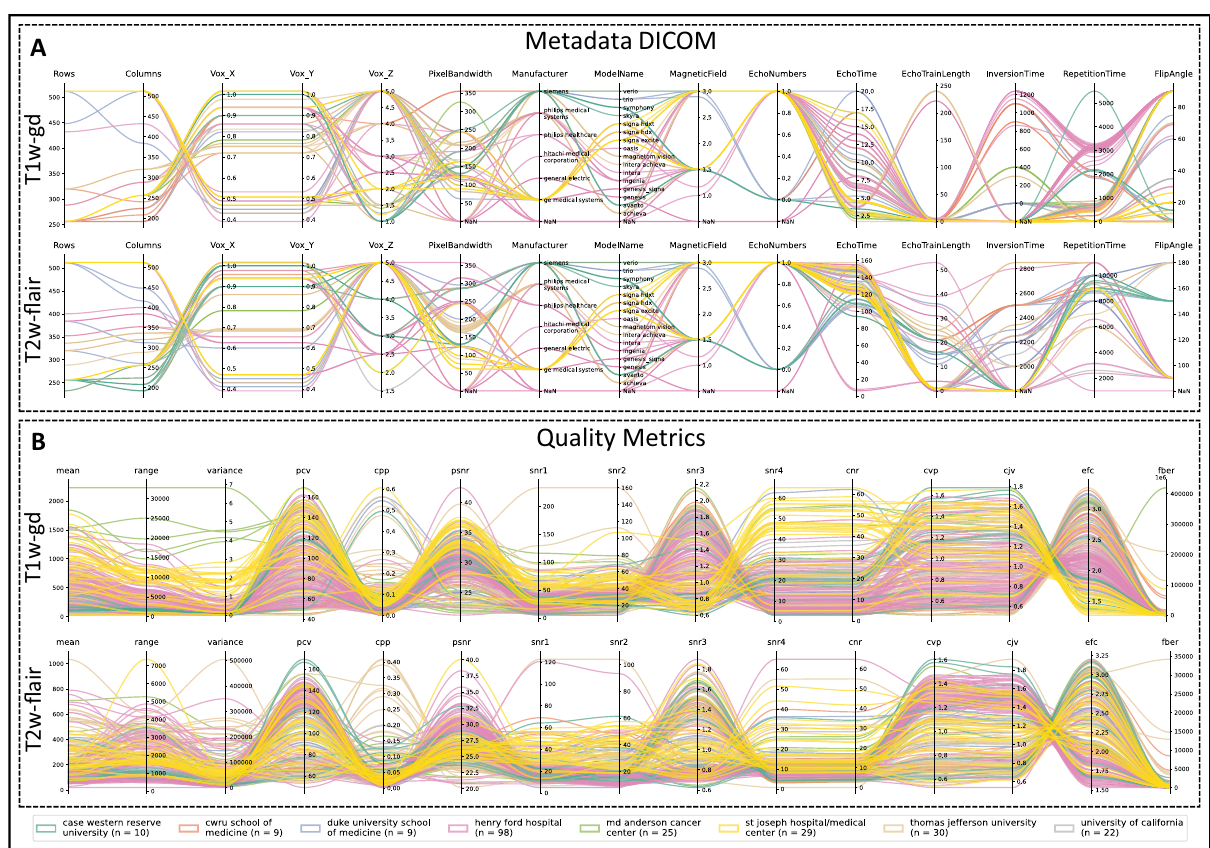
Figure 3. Parallel coordinate plots per center of the information extracted from the dataset for the T1w-gd and T2w-flair MRI. ( a ) Information extracted from the header of the DICOM files. ( b ) Measurement of quality